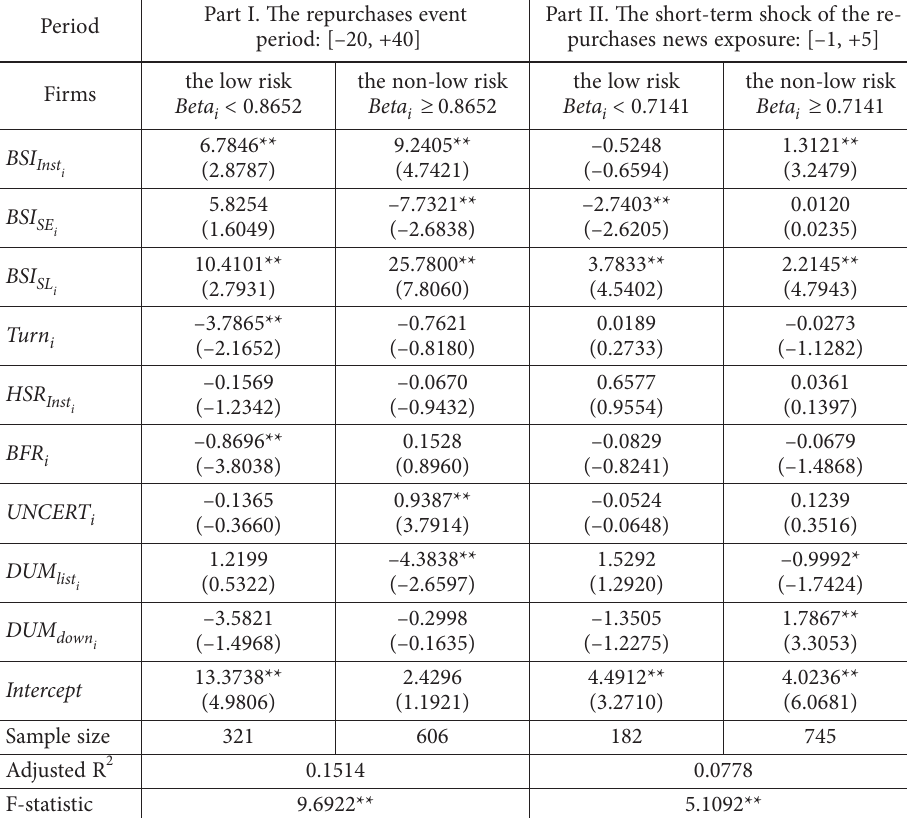
Table 5. The results of the estimated parameters of the threshold regression model